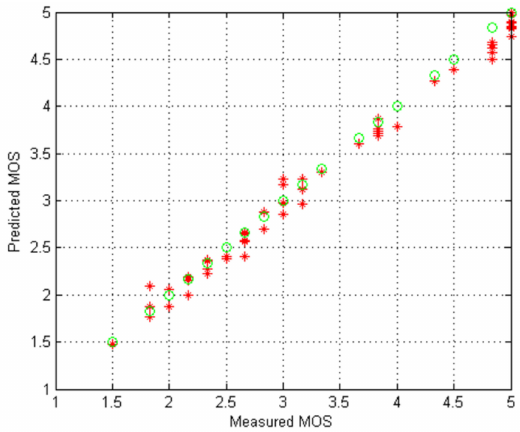
Figure 19. Subjective MOS vs. predicted MOS for all devices.